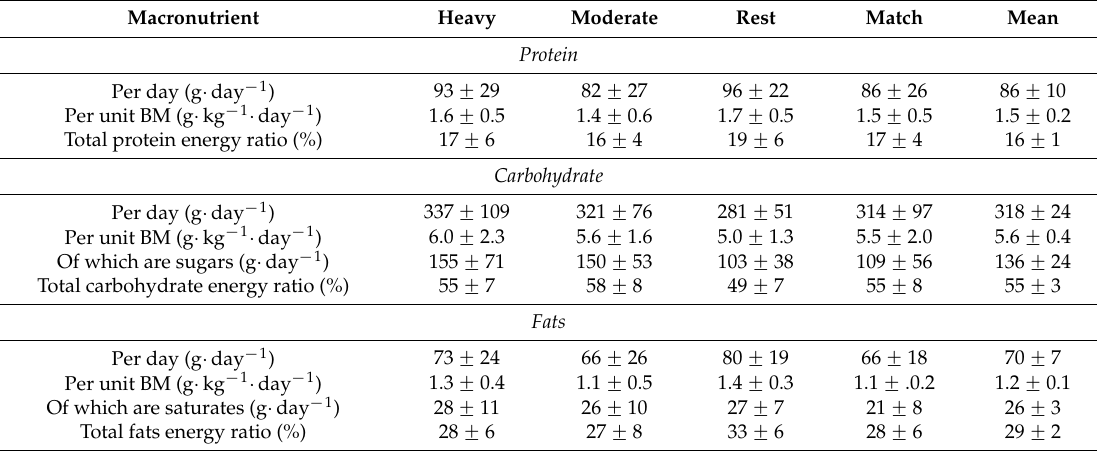
Table 2. Mean macronutrient intakes of adolescent soccer player’s diets broken down by type of activity day (mean ˘